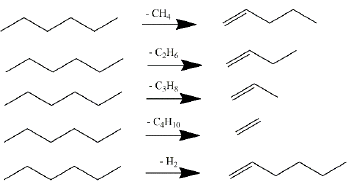
Table 1. Comparison of experimental results from fixed bed reactor recorded at different weighted hourly space velocity (WHSV) and Temperature..